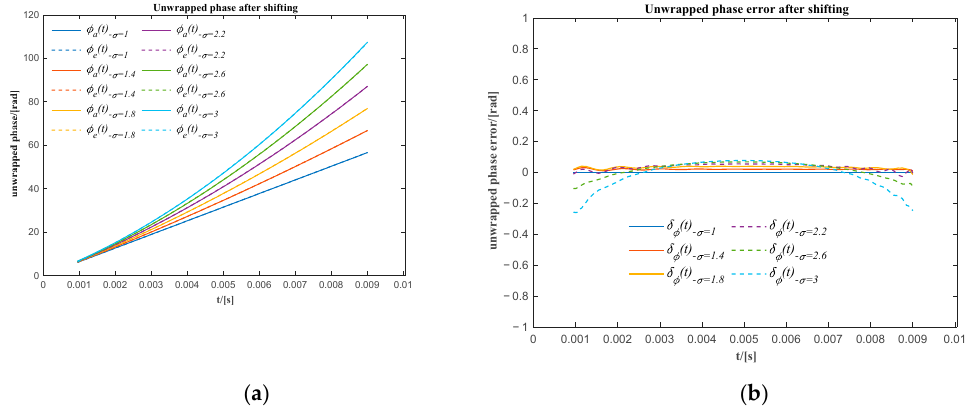
Figure 6. ( a ) The actual and the extracted unwrapped phase for different relative frequency ratios after phase shifting; ( b ) the phase error of the extracted unwrapped phase using the sum of the first two sub-signals after phase shifting.